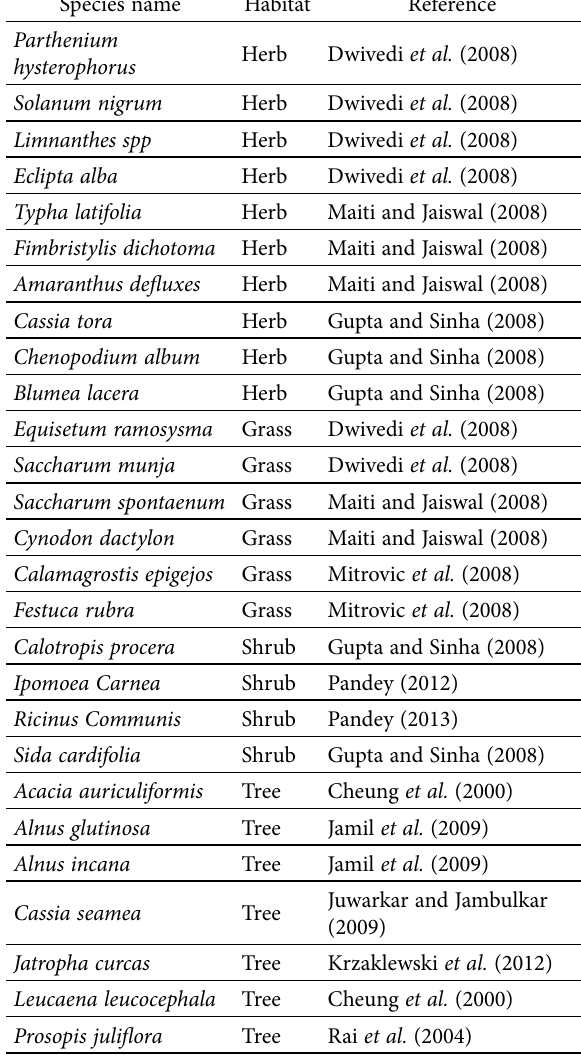
Table 1. Plant species used for vegetation establishment on